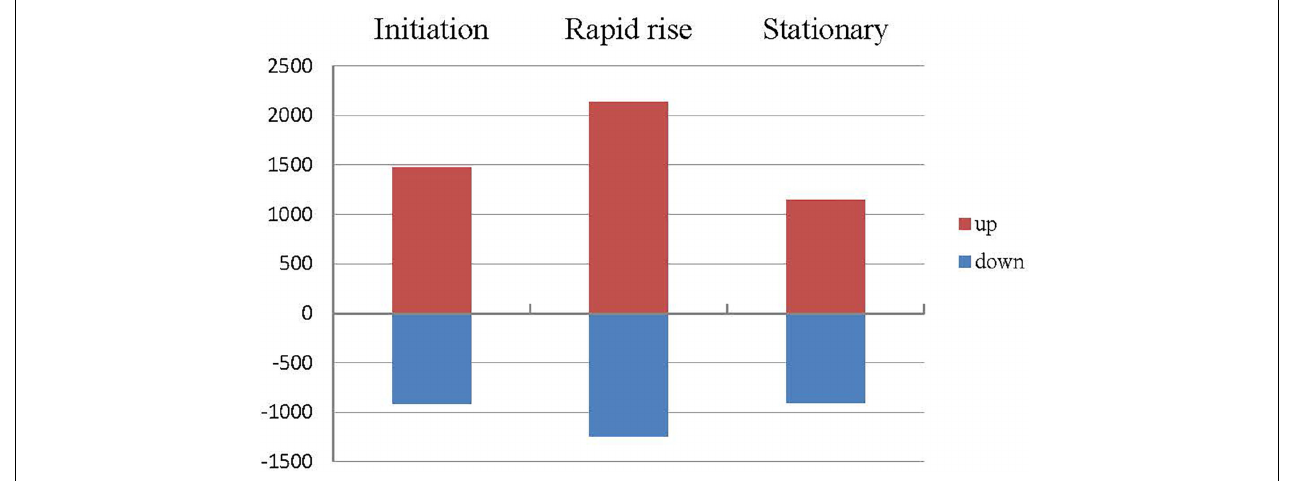
FIGURE 2 | Differentially expressed genes (DEGs) related to fatty acids metabolism between ‘Xifei’ and ‘Dielsii’ at initiation, rapid rise and stationary stage of kernel development, respectively.